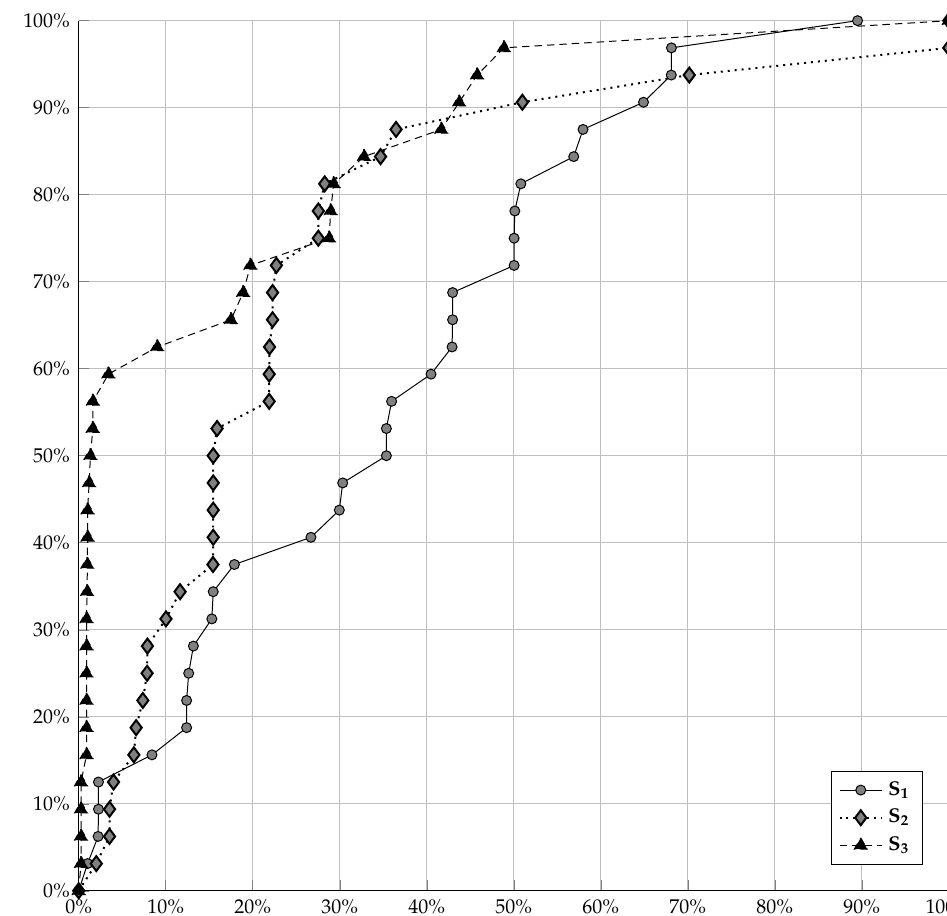
Figure 10. Plots of dependences U ( V ) in the forecast from the fields S 1 (density of the earthquake epicenters with Gaussian Kernel smoothing), S 2 (density of the earthquake epicenters with AWS), and S 3 (AWS of S 1